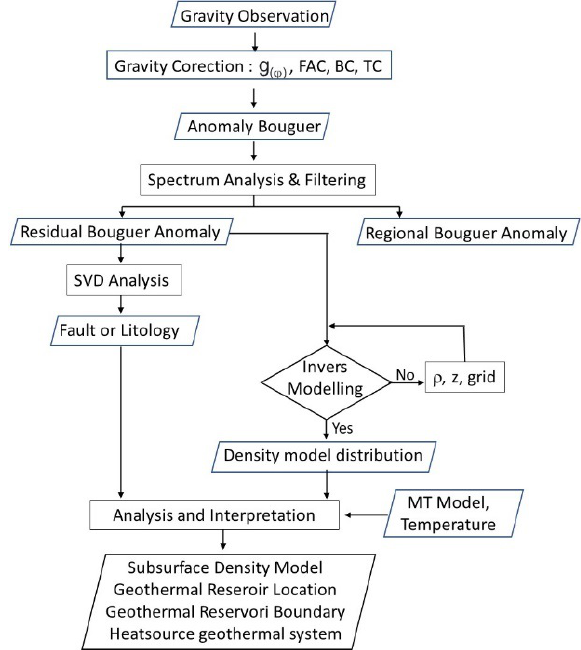
Fig. 5. Flowchart of research in determining the boundary of a geothermal reservoir